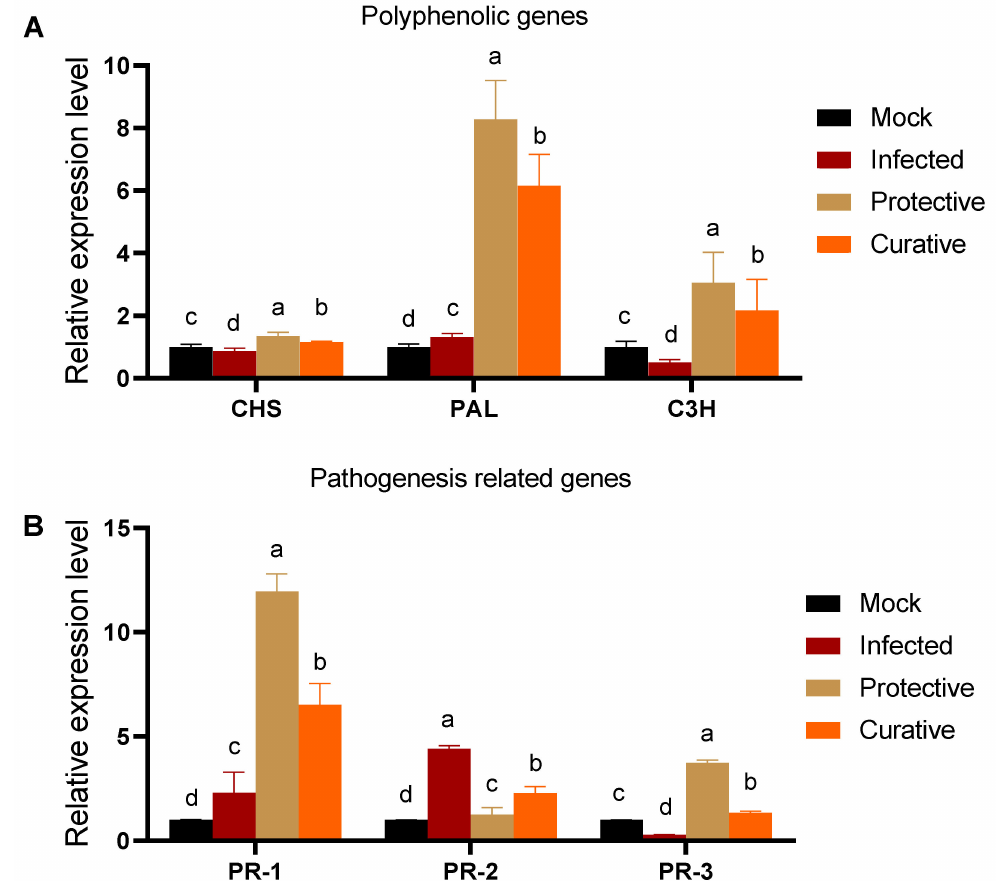
Figure 6. Relative expression levels of three polyphenolics ( A ) and three pathogenesis-related genes ( B ) in squash plants. Mock: squash plants foliar sprayed with sterile nutrient broth and mocked with viral inoculation buffer; infected: squash plants mechanically inoculated with ZYMV with foliar spraying of sterile nutrient broth; protective: squash plants sprayed with Paenibacillus polymyxa strain SZYM-CF 24 h before ZYMV inoculation; curative: squash plants sprayed with SZYM-CF 24 h after ZYMV inoculation. The mean values of each column with the same letter do not differ